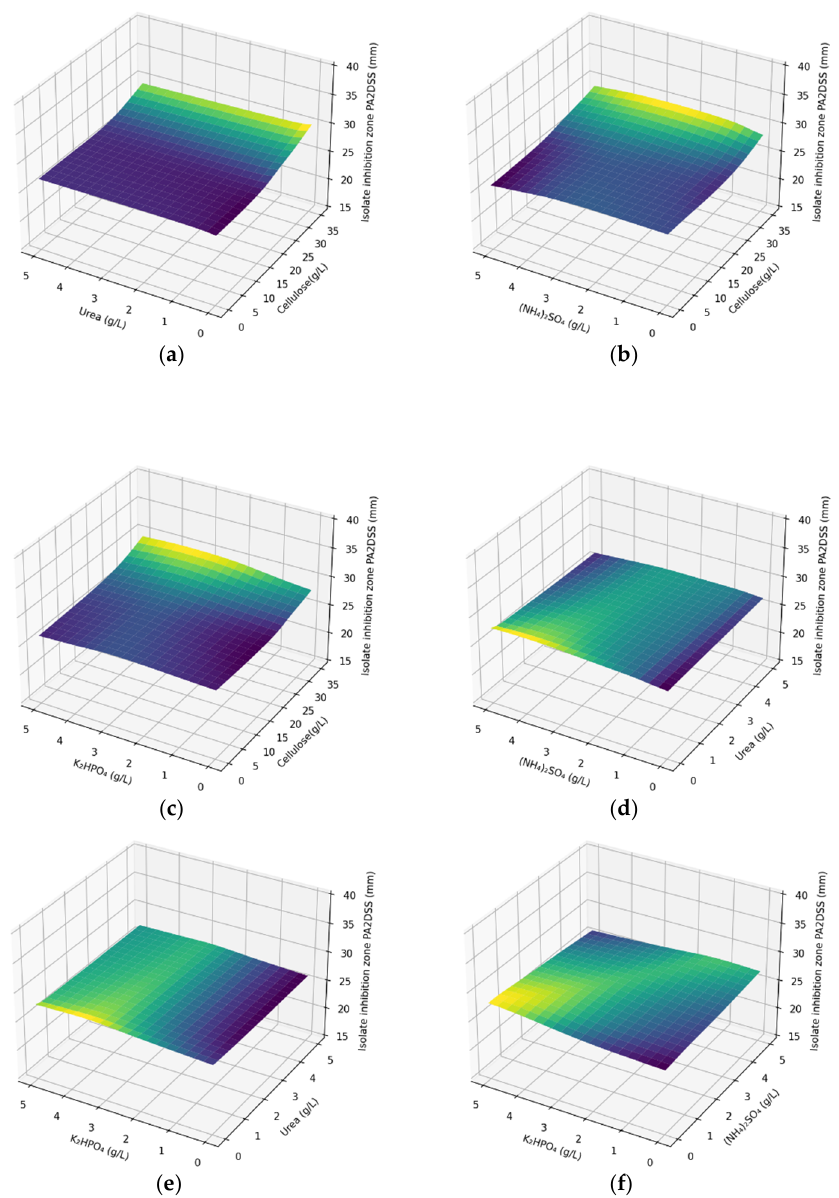
Figure A4. Response surface plots for effects of nutrients’ content on inhibition-zone diameter for Aspergillus flavus PA2DSS (ANN methodology): ( a ) cellulose and urea, ( b ) cellulose and (NH 4 ) 2 SO 4 , ( c ) cellulose and K 2 HPO 4 , ( d ) urea and (NH 4 ) 2 SO 4 , ( e ) K 2 HPO 4 and urea, ( f ) K 2 HPO 4 , and (NH 4 ) 2 SO 4 .